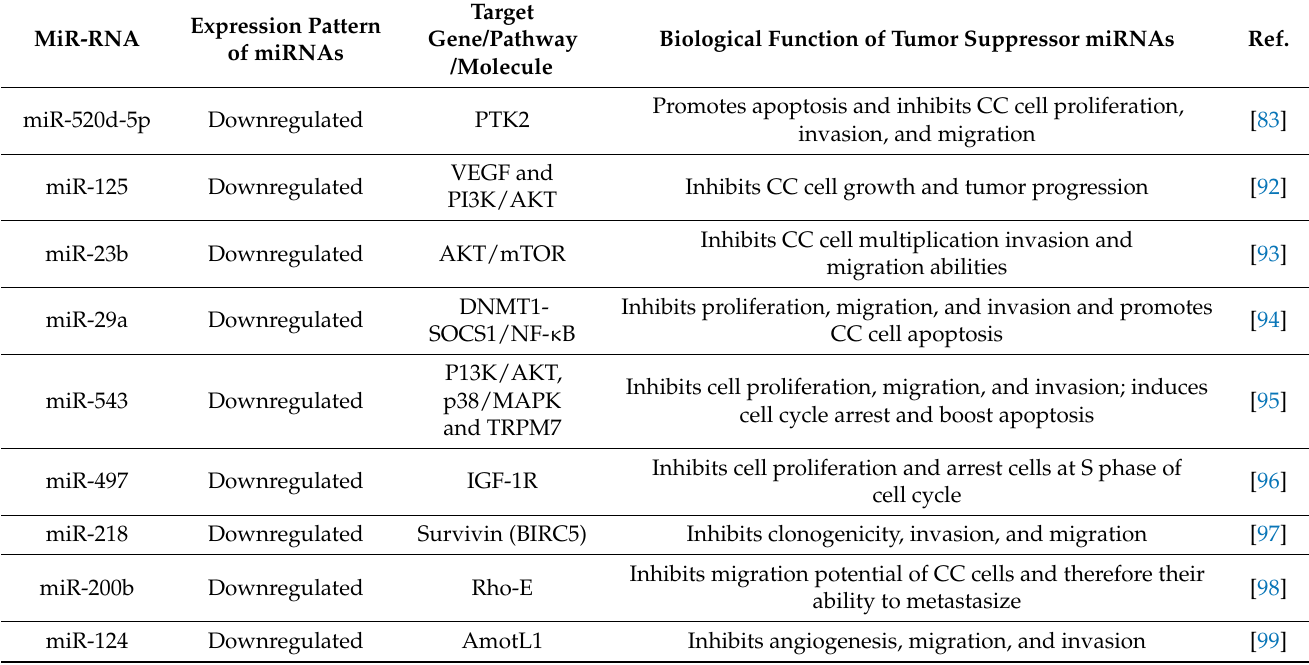
Table 2. Summary of selected tumor suppressor miRNAs with their functional effect in